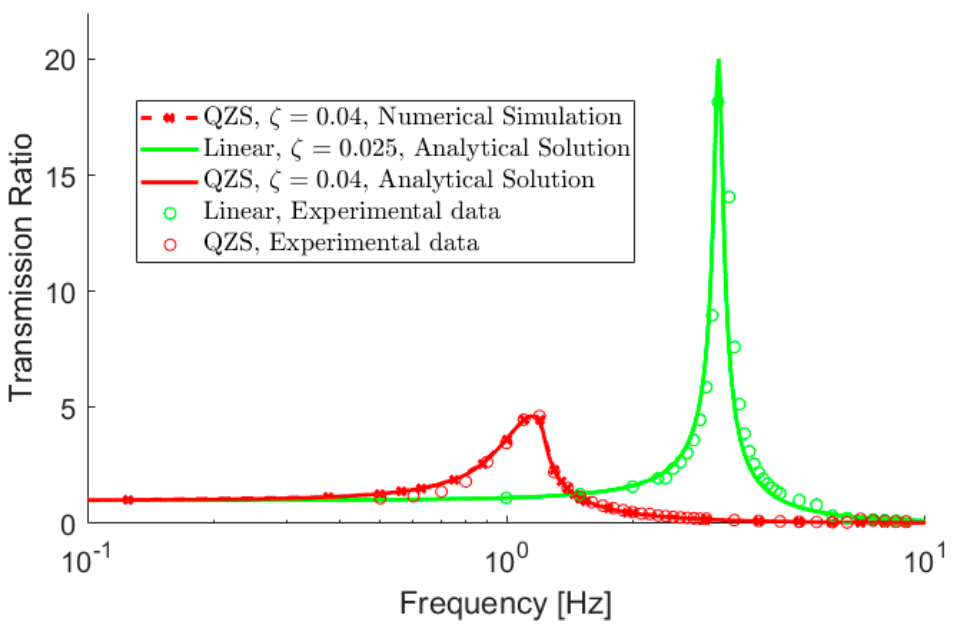
Figure 7. Comparison of experimental, analytical, and numerical results for Half 1 of the prototype linear and HSLD systems. System parameters are summarized in Table 1.